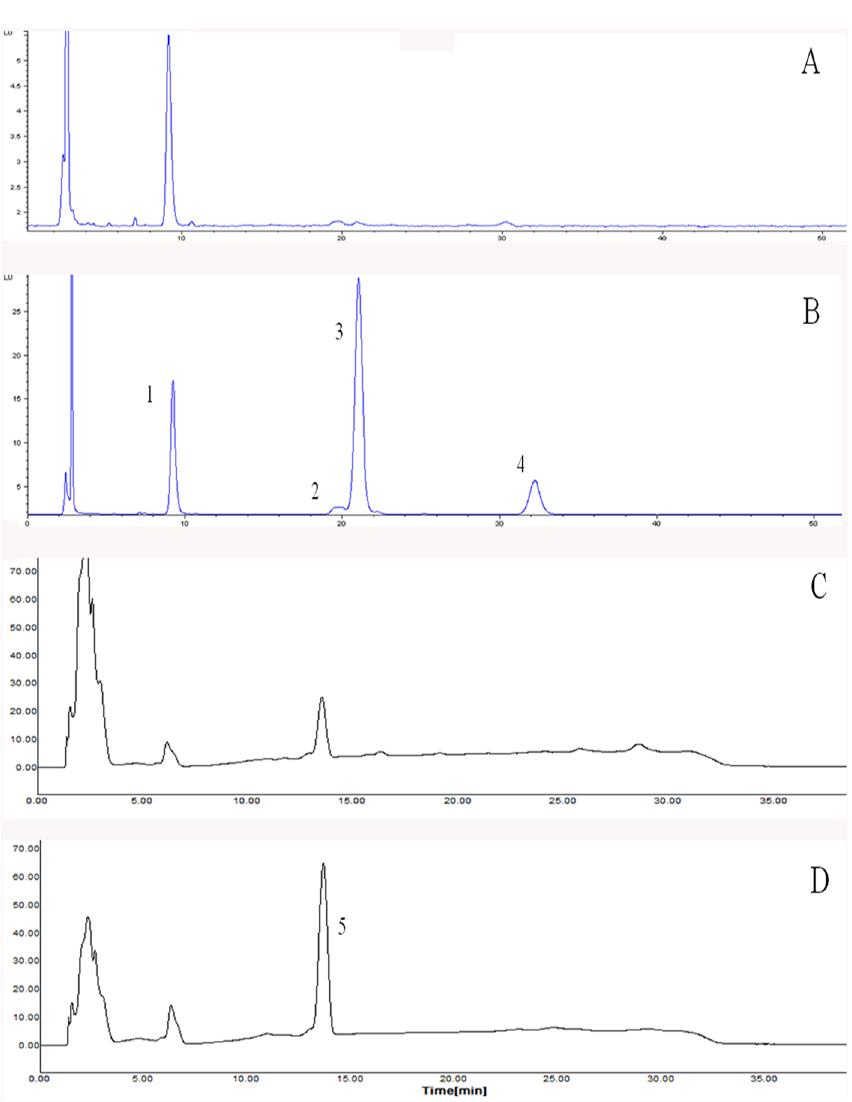
Fig 1. Chromatogram of tocopherols(A: raw red pepper, B: deep-friedred pepper)and β -carotene(C: raw red pepper, D: deep-friedred pepper).Peak identification: (1) α -tocopherol,(2) β -tocopherol,(3) γ -tocopherol, (4) δ -tocopherol, (5) β